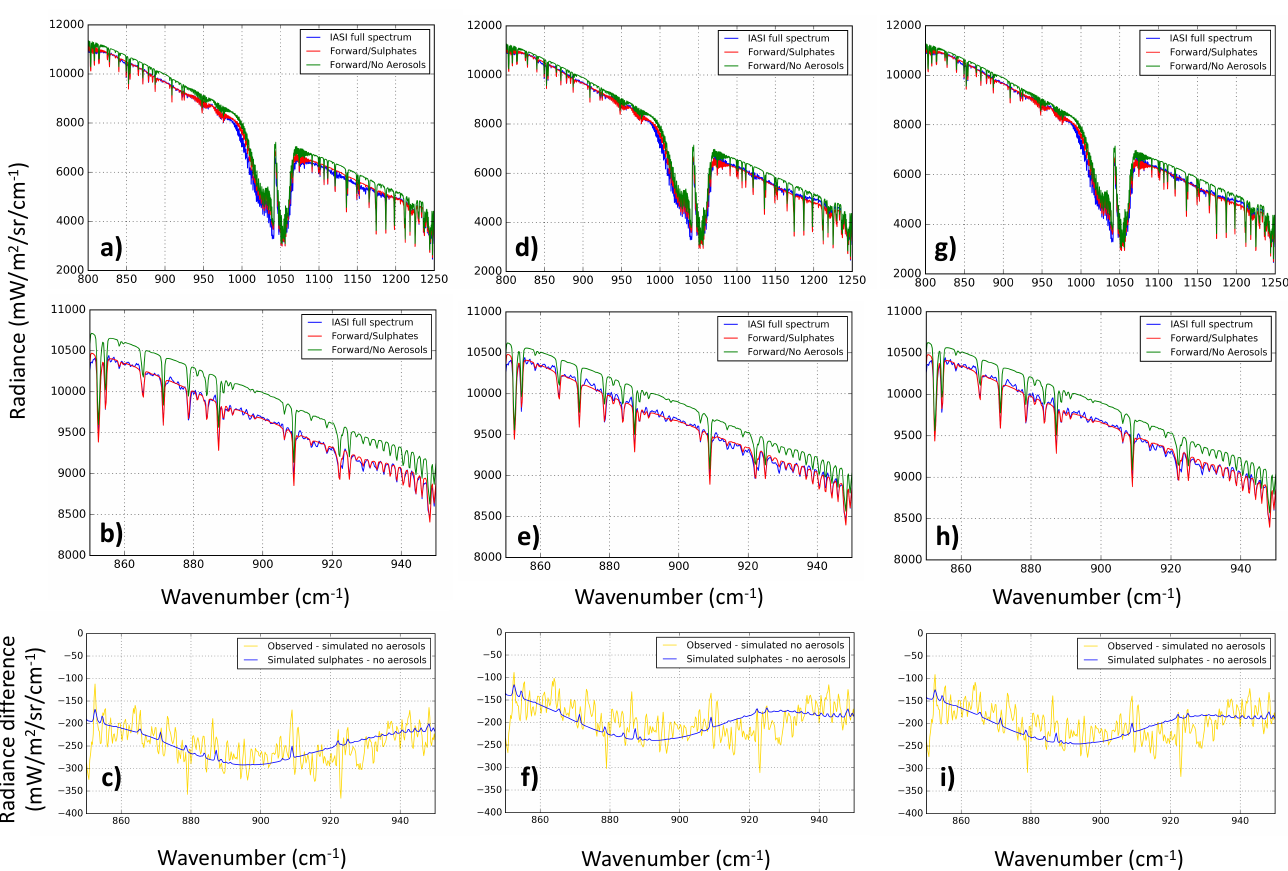
Figure 1. ( a ) An IASI spectrum (blue) taken in the Mount Etna plume observed during daytime overpass on 19 March 2012 (location identified with a black cross in Figure 3). The AEROIASI-H2SO4 fitted spectrum is shown in red and a fitted spectrum without SA is in green; ( b ) same as ( a ), but in the spectral range 850–950 cm − 1 ; ( c ) spectral radiance differences of the IASI observed spectrum and the fitted spectrum without SA (yellow) and of the fitted spectra with and without SA (blue). In ( a – c ), the following SA size distribution is considered: log-normal distribution with mean radius 0.50 µ m and standard deviation 0.50; ( d – f ) the same as ( a – c ) but for a different SA size distribution (log-normal distribution with mean radius 0.20 µ m and standard deviation 0.20); ( g – i ) same as ( a – c ) but for a different SA size distribution (log-normal distribution with mean radius 0.20 µ m and standard deviation